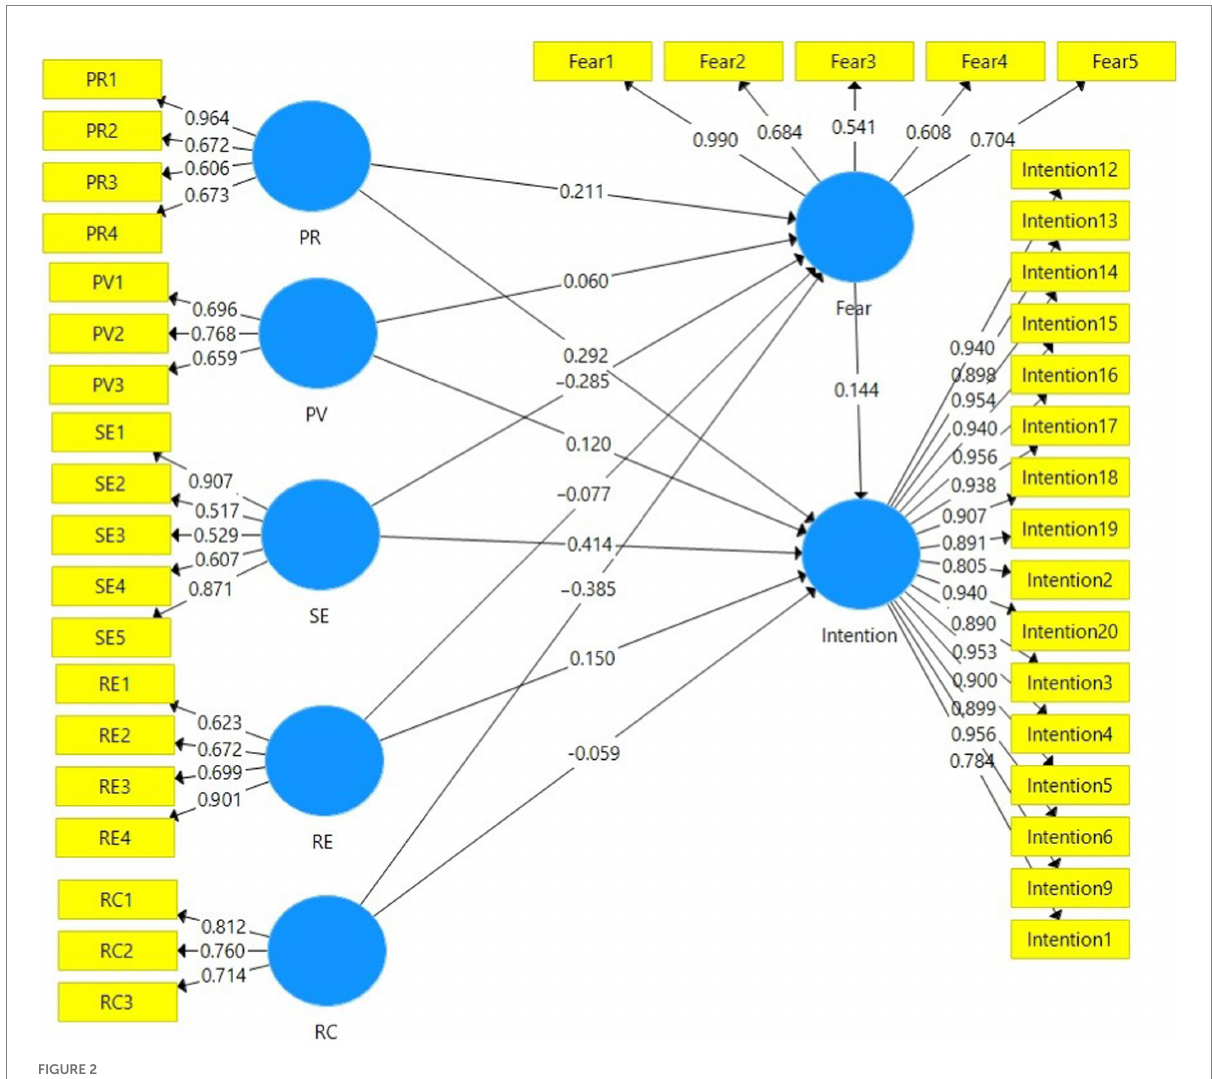
FIGURE 2 Structural model of mediated